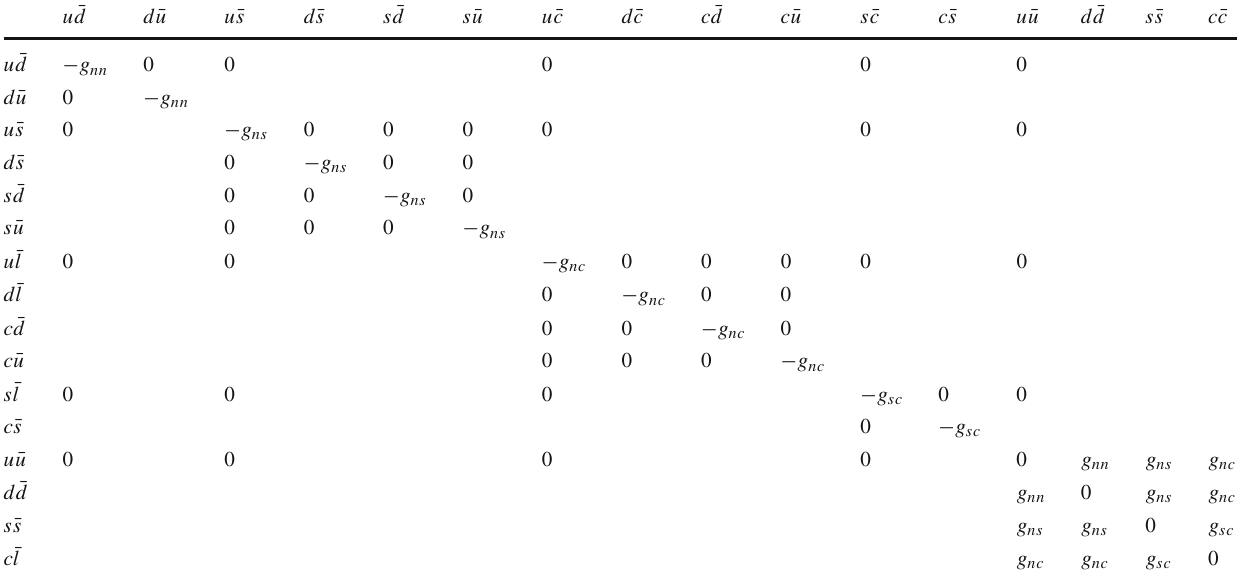
is flavor-dependent model parameter, n = u , d stands for light